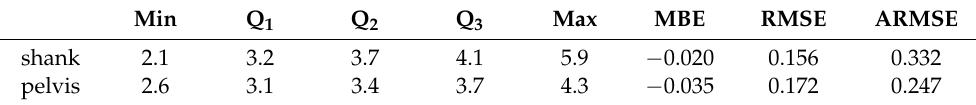
Table 6. Statistics relevant to the target OW-APV REF and to its estimation, in km/h (validation performed using the OW dataset; shank and pelvis indicate the site used to compute the target). Min Q 1 Q 2